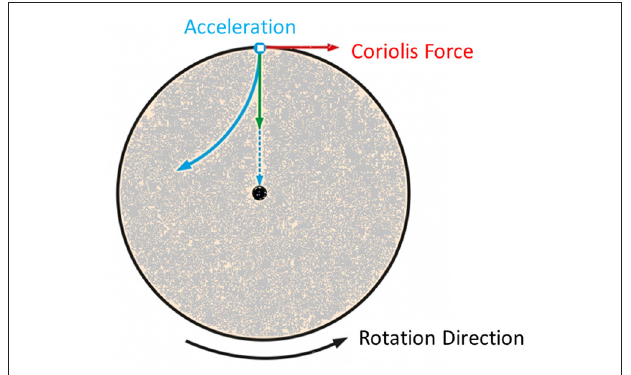
FIGURE 1 | Visualization of the forces induced due to centrifugation and more specifically the Coriolis force.